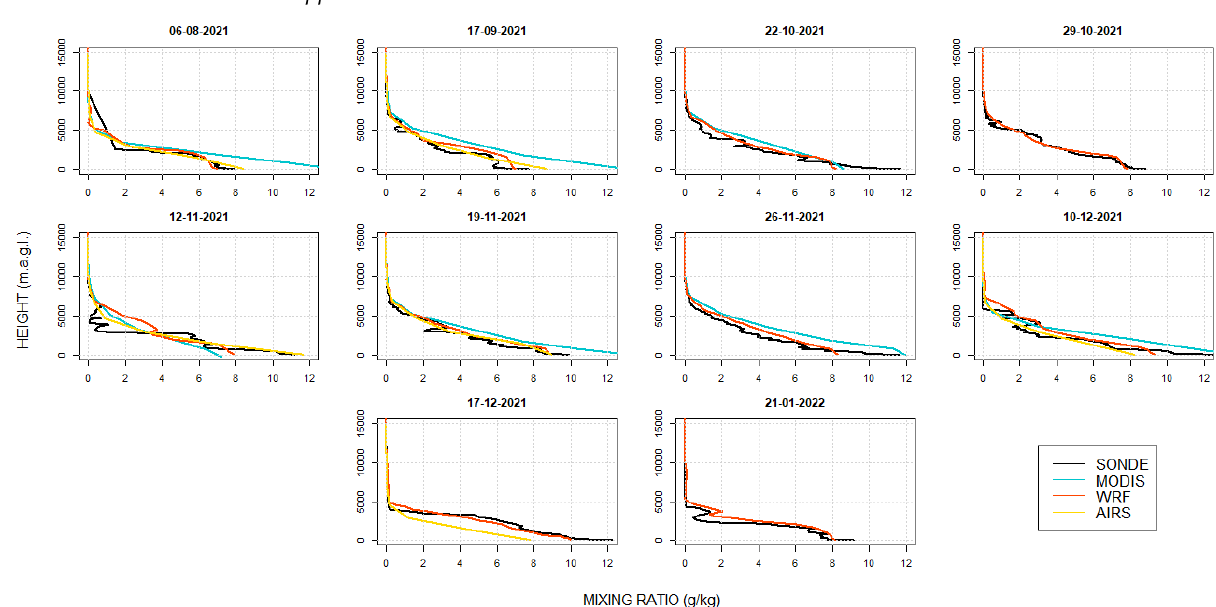
Figure A3. Mixing ratio profiles measured with radiosonde (black), drone (green), MODIS (sky-blue), AIRS (yellow), and WRF (orange) up to 15,000 magl. for 10 measurement events.